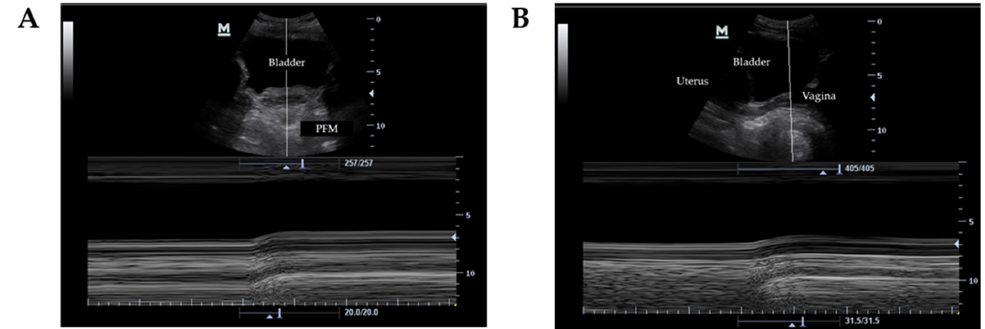
Figure 1. Ultrasound of the bladder base displacement in motion mode M. ( A ) MVC of PFM in transversal plane. ( B ) MVC of PFM in sagittal plane. J. Clin. Med. 2022 , 12 , x FOR PEER REVIEW